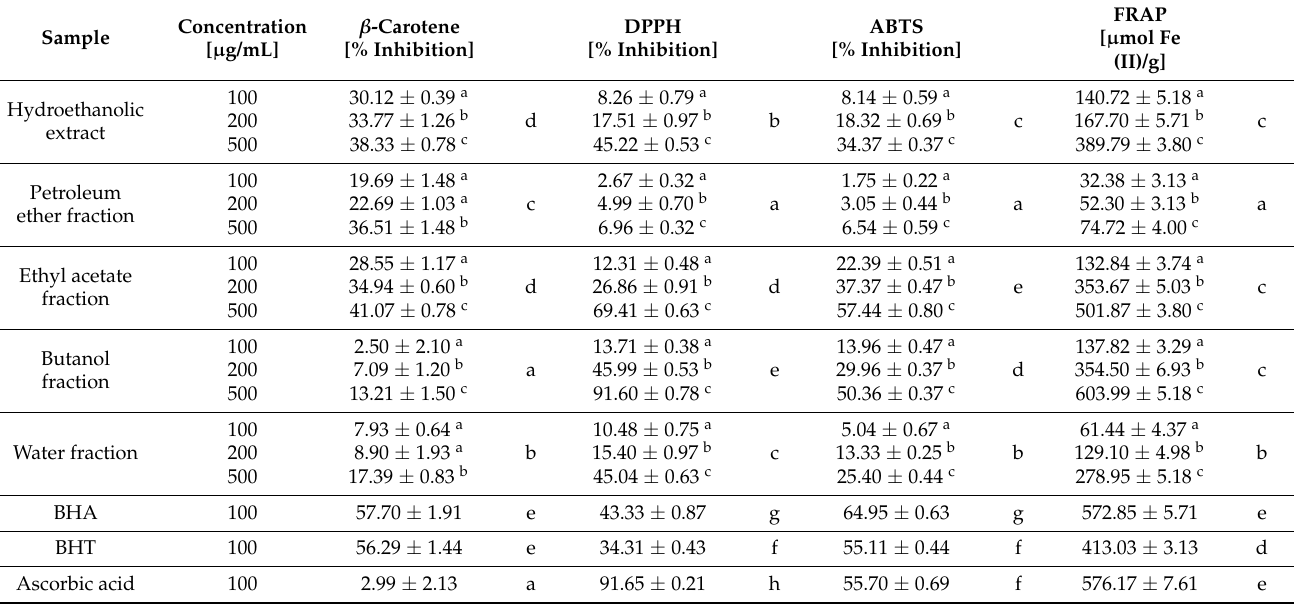
Table 2. Antioxidant activity of the hydroethanolic extract of the aerial parts of Sideritis raeseri subsp. raeseri and its fractions.